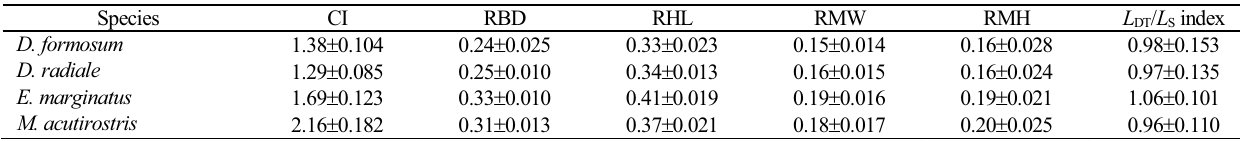
Table 1. Ecomorphological attributes (average ± standard deviation) calculated for Diplectrum formosum (n=12; SL>130 mm); D. radiale (n=27; SL>130 mm); Epinephelus marginatus (n=13; 200-305 mm SL); and Mycteroperca acutirostris (n=11; 180- 247 mm SL). CI = compression index; RBD = relative body depth; RHL = relative head length; RMW = relative mouth width; RMH = relative mouth height; L / L index = intestinal ratio (intraspecific variations of the gut length were mainly related to DT S the amount of food and/or feces